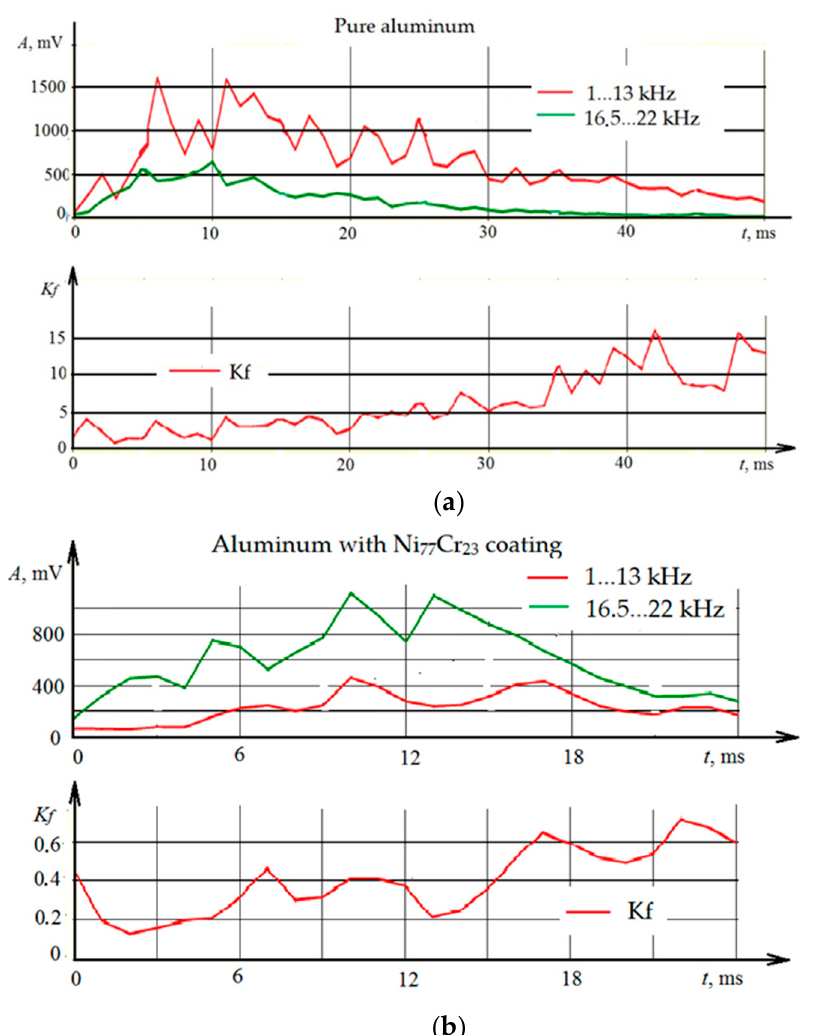
Figure 25. The envelopes of the VA signals in the low-frequency (1–13 kHz) and high-frequency (16.5–22 kHz) ranges and the K f coefficient when irradiated with pure aluminum ( a ) and aluminum with Ni 77 Cr 23 coating ( b ).